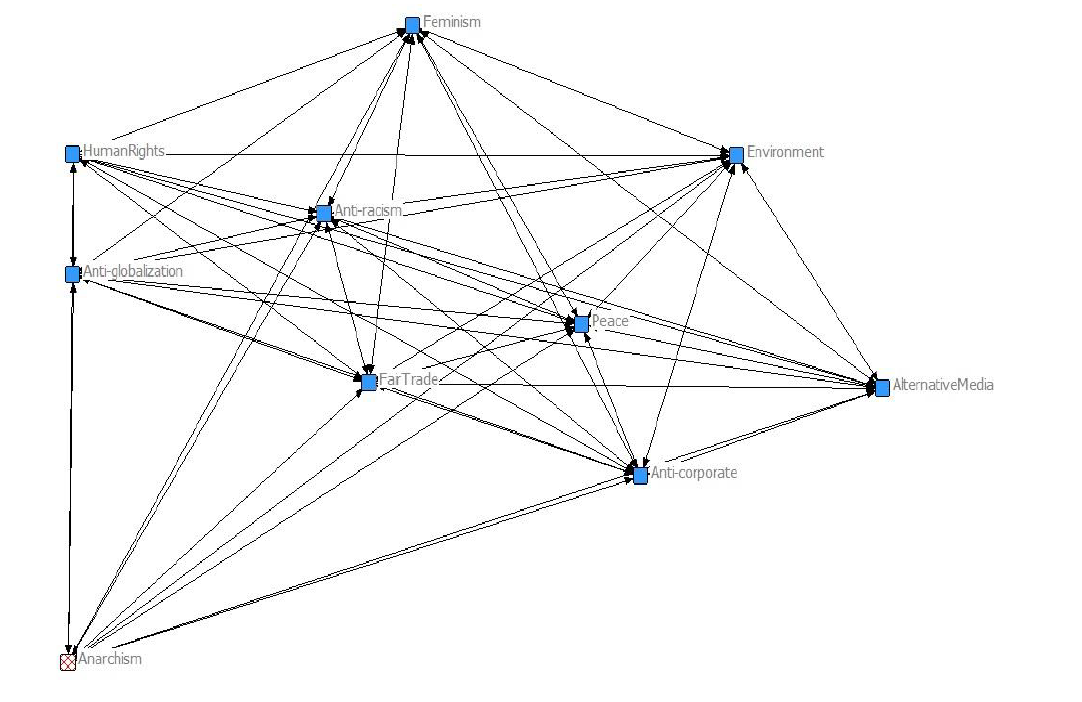
Figure 1 uses the combined data from Nairobi, Atlanta and Detroit with 27 movement